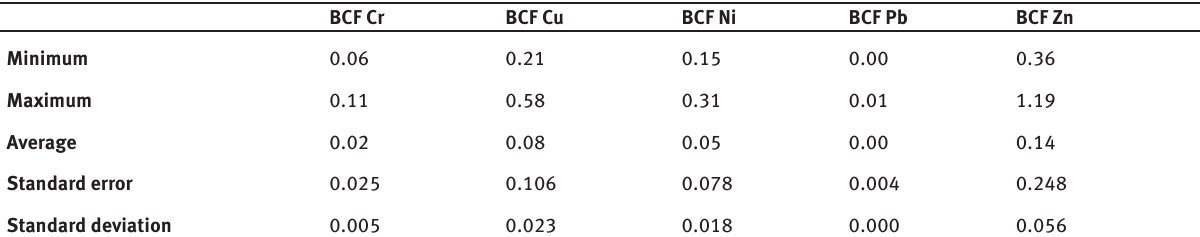
Table 4: Biological concentration factor of heavy metals in Z. coccinea grown around the cement